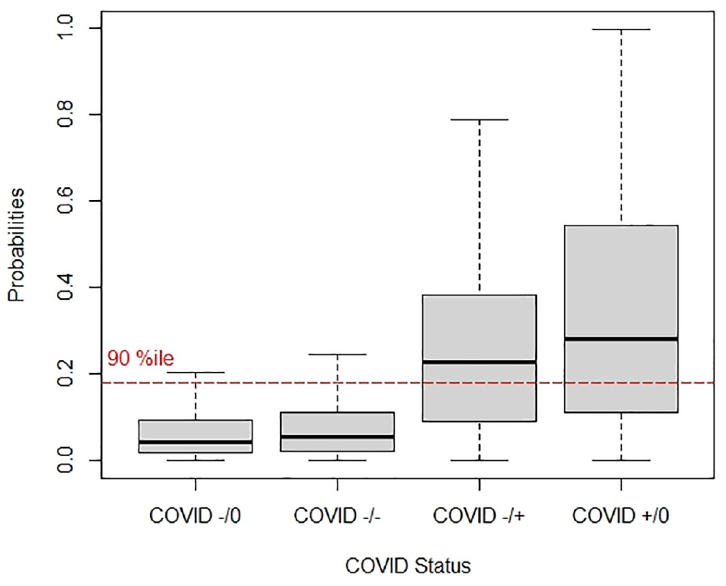
Fig 3. Prediction model probabilities of testing positive for COVID among subpopulations. COVID +/0: tested positive for COVID on admission and was not retested within 4 days. COVID -/0: tested negative for COVID on admission and was not retested within 4 days. COVID -/+: tested positive for COVID on admission and upon retesting (within 4 days) tested positive for COVID. COVID -/-: tested negative for COVID on admission and upon retesting (within 4 days) tested negative for